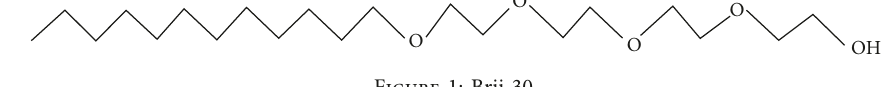
Figure 1: Brij 30.